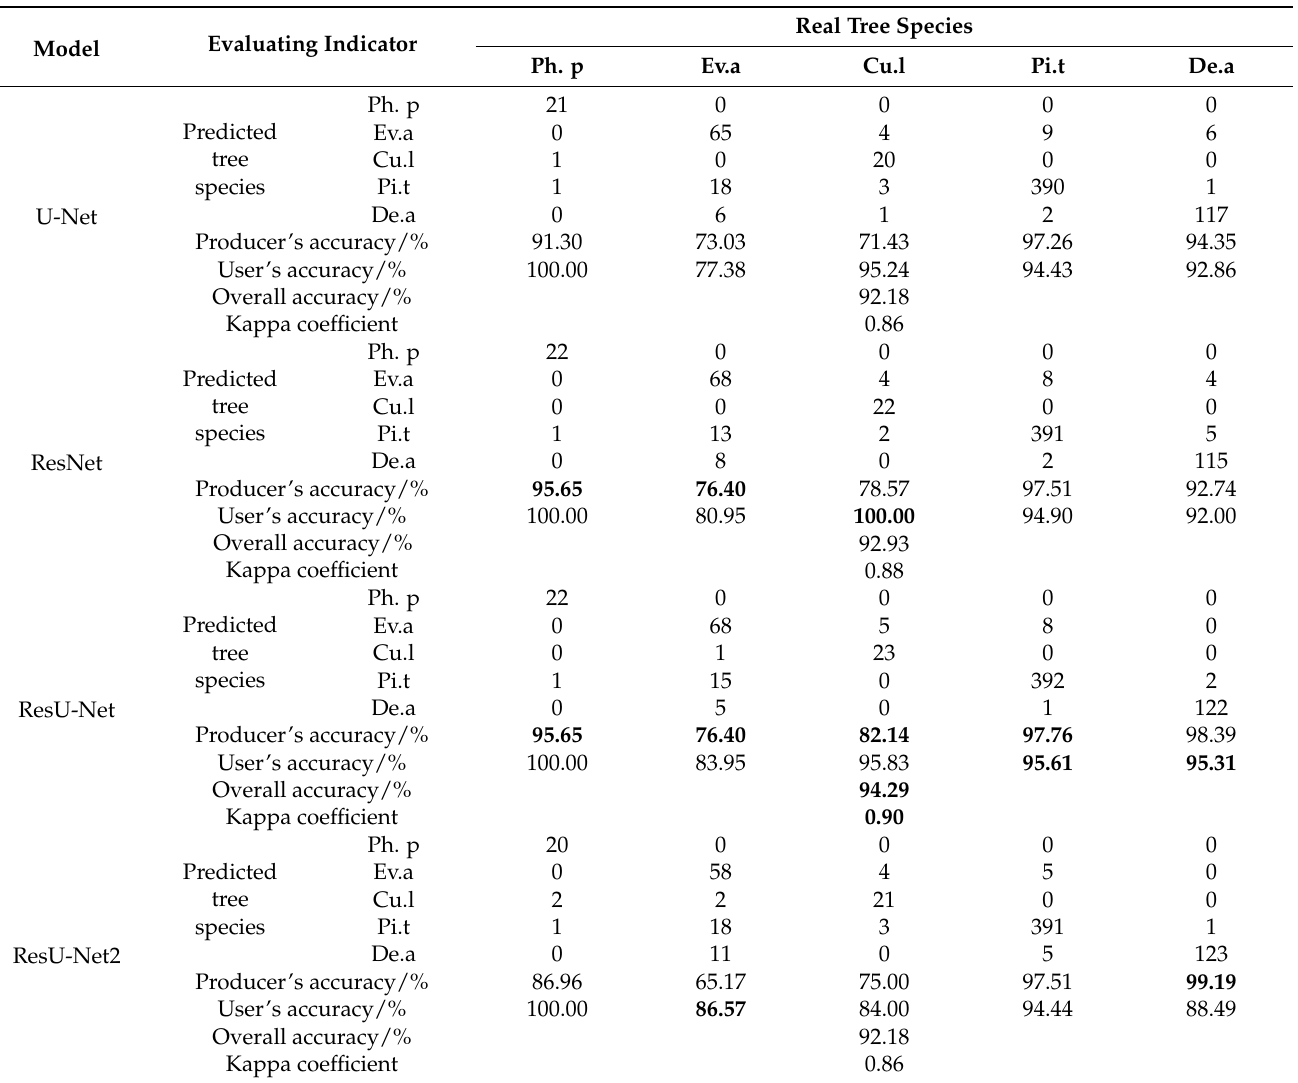
Table 5. The evaluation of model classification